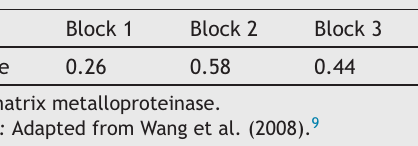
MMP-9 polymorphisms, under three genetic models, and their relationships with nasal polyposis.